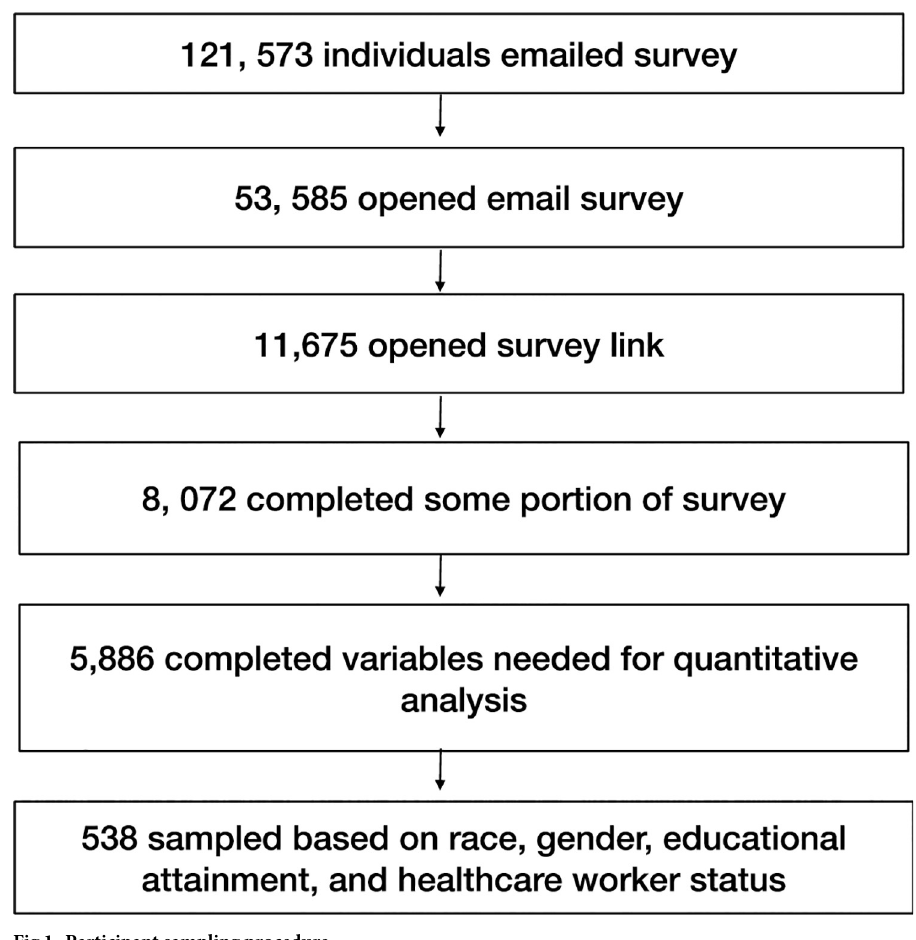
Fig 1. Participant sampling